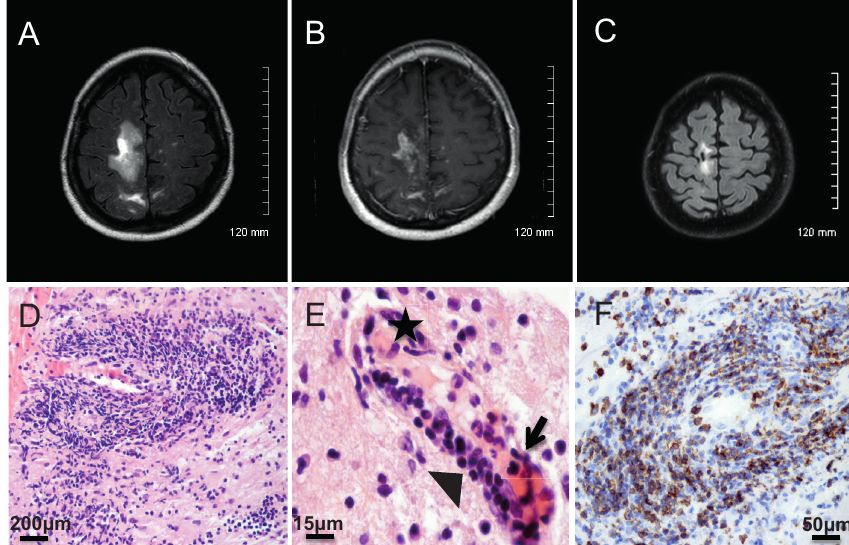
Figure 2. Brain MRI and histopathology. A – B : Brain MRI at the onset of the simultaneous PML-IRIS showing white matter hyperintensities of the right frontal and parietal region (A, axial T2-WI) with multiple foci of gadolinium enhancement (B, axial T1-WI). C : Brain MRI nine months after the onset of PML-IRIS showing sequellar lesions (axial T2-WI). D – E : Histopathology showing severe perivascular infiltrates (D, H&E × 200) with a vasculitic component (E, H&E × 630, star: fibrin deposit, arrow: neutrophils and serohematic material, arrowhead: lymphocytes infiltrating vessel wall). F : Immunohistochemistry analysis (×400) showing perivascular inflammatory infiltrates positive for CD3 antibody (clone F7.2.38,